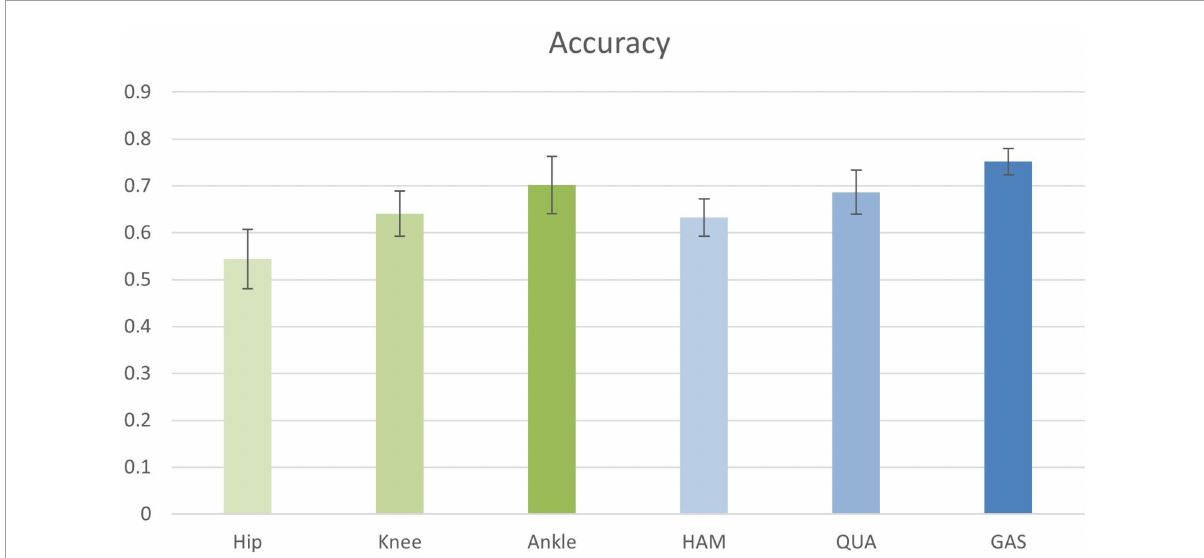
FIGURE8 Classification accuracy of joint kinematics and muscle group conformation. The accuracy values shown in the figure are the result of the best performance of the post-configuration threshold selection between 0.7 and 0.85.